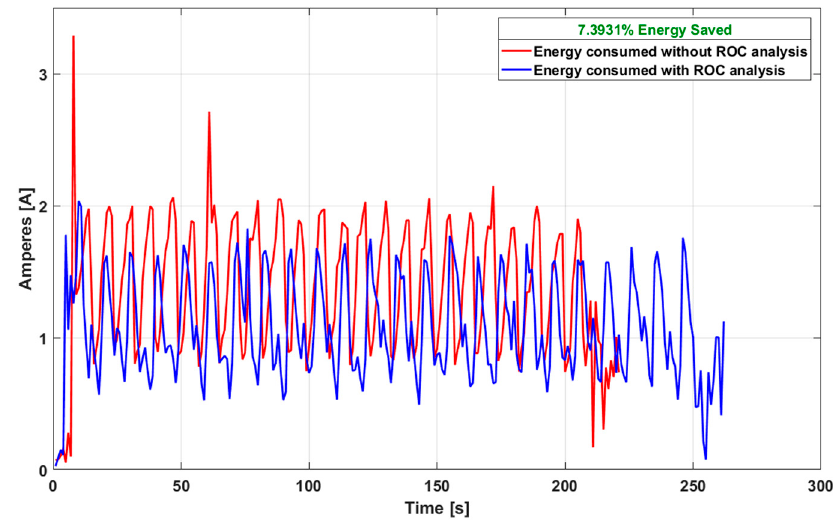
Figure 18. Top view of robotic system travel without consideration of curvature analysis and with consideration of curvature analysis. ( a ) without ROC analysis, ( b ) With ROC analysis.